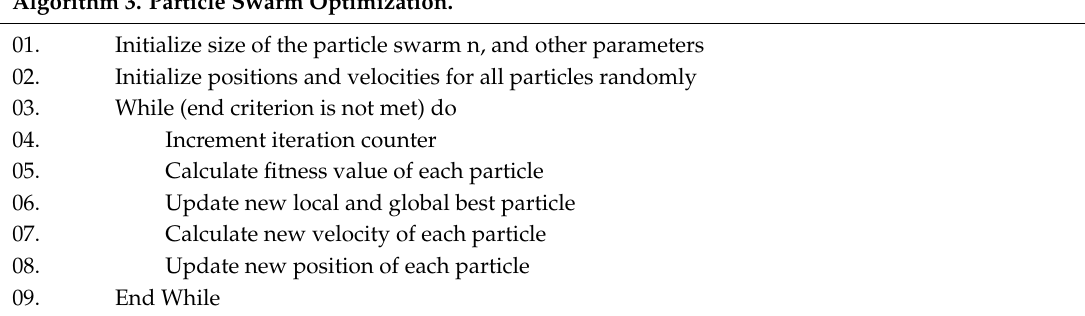
Algorithm 3. Particle Swarm Optimization.